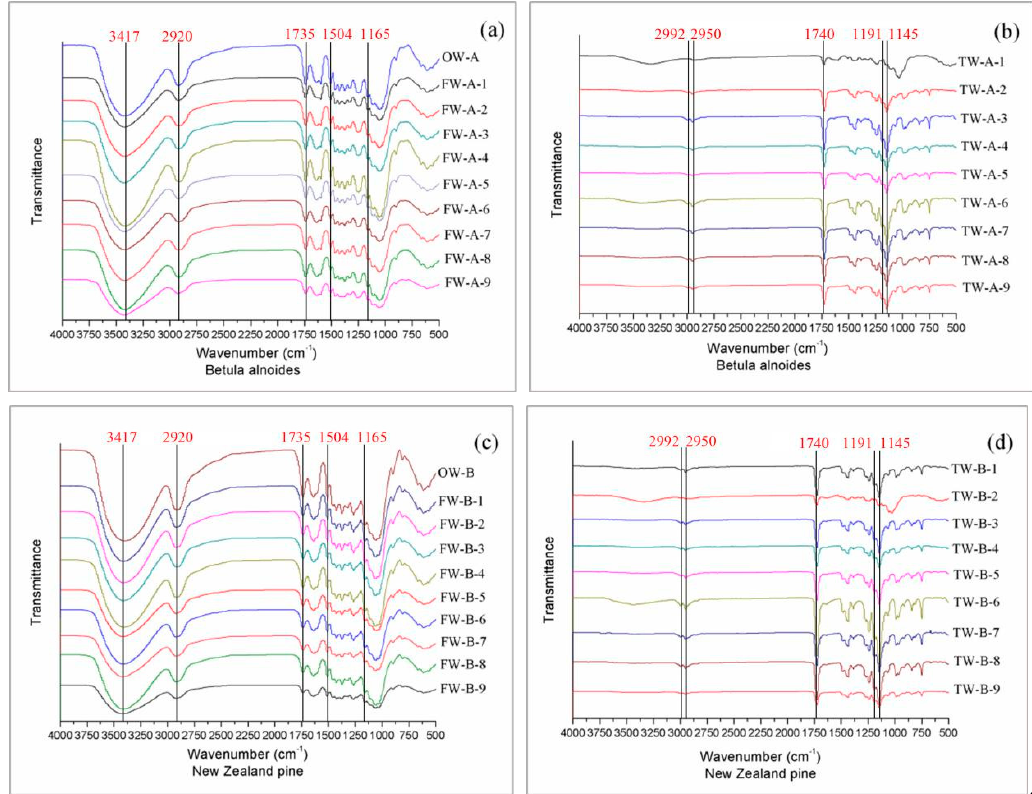
Figure 8. The infrared spectrum of OW, FW and TW for two tree species corresponding to ( a ), ( b ), ( c ) and ( d ).